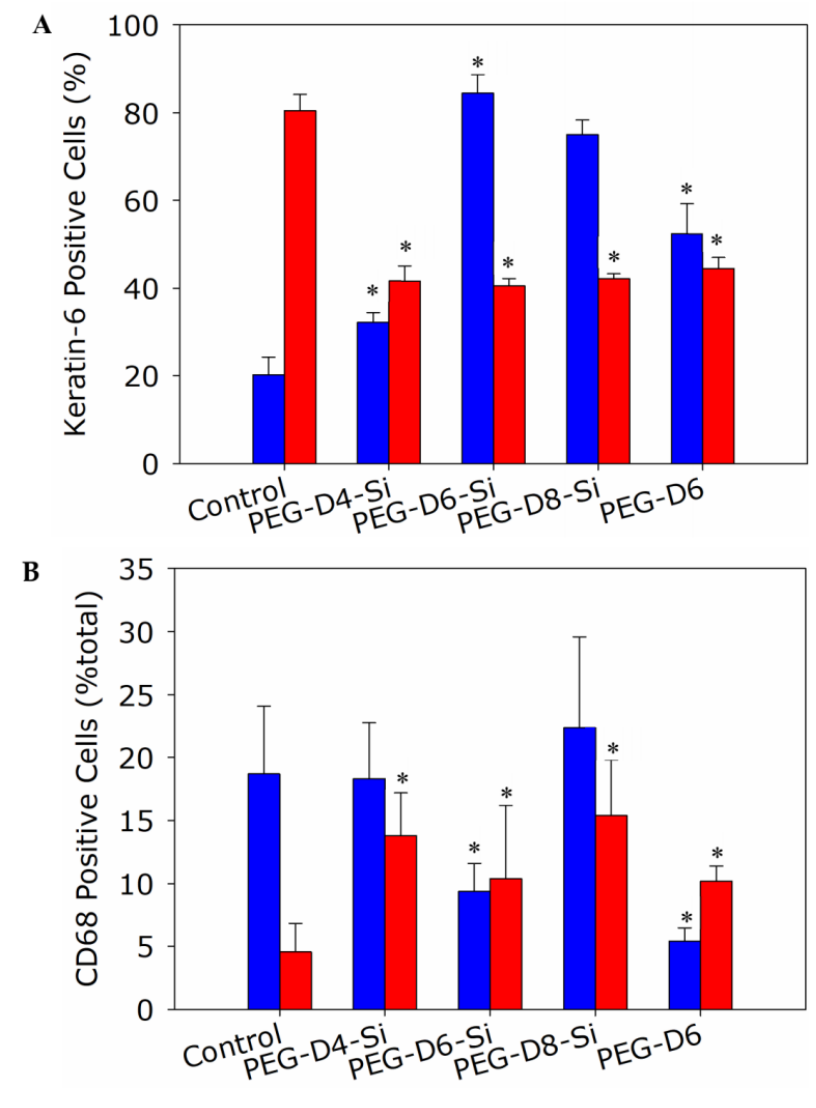
Figure 14. Percentage of keratin-6- ( A ) and CD68- ( B ) positive cells in the wound site treated with various adhesive formulations on days 7 ( (cid:4) ) and 14 ( (cid:4) ) post-surgery. Number of repeats is 3. * p < 0.05 when compared to the control at the given time